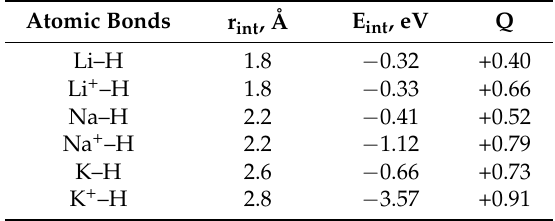
-0.3-0.2-0.1 Figure 5. Energy curves of the scanning process of an arbitrary surface containing with atoms and ions: 1 Li atom; 2 K atom; 3 Na atom; 4 Li + ion; 5 Na + ion; 6 K + ion, surface-modified system -0.5 -0.4